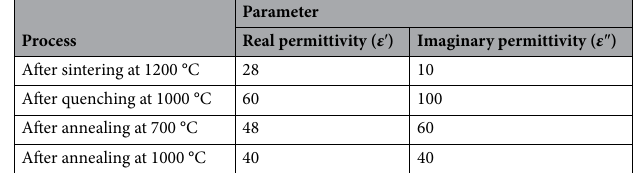
Table 3. The real ( ε ′ ) and imaginary ( ε ″ ) permittivity after sintering, quenching and after annealing at 3 MHz.